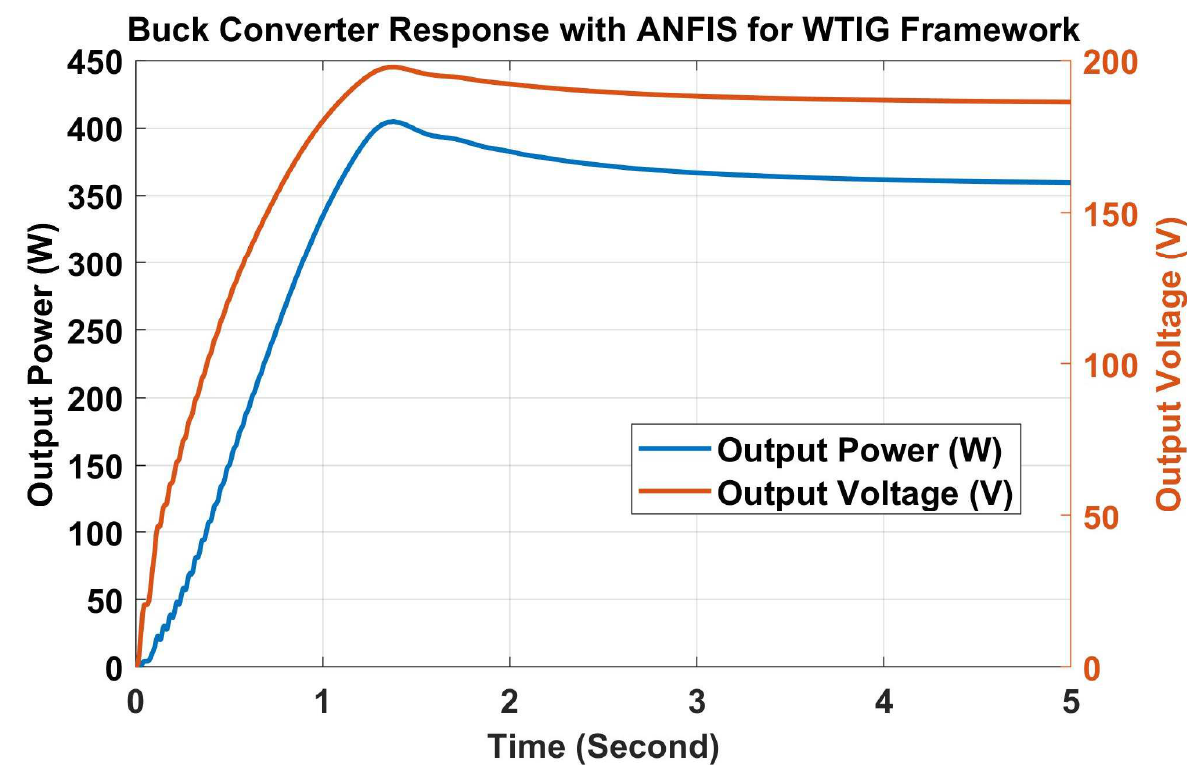
Figure 31. Output Power and Voltage of Boost Converter with AN-FIS MPPT for PV Framework.